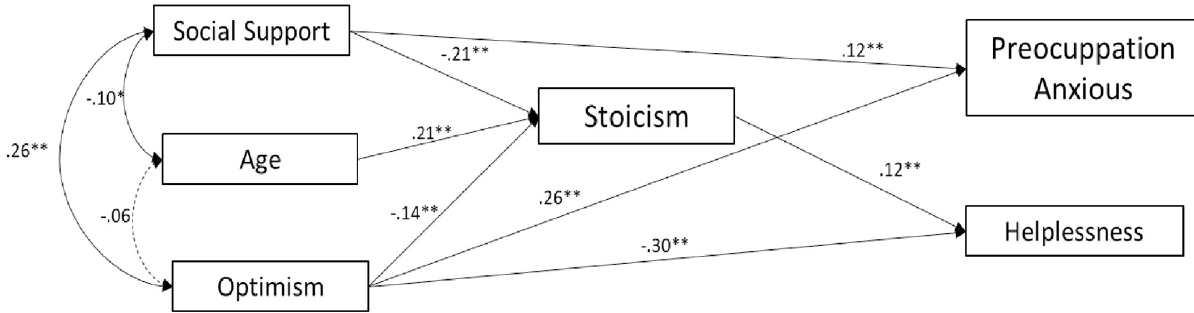
Fig 2. Tested study model: Relationship between stoicism and psychological variables in women. Note: Dashed lines indicate statistically non- significant paths. � p < 0.01; �� p < 0.001.